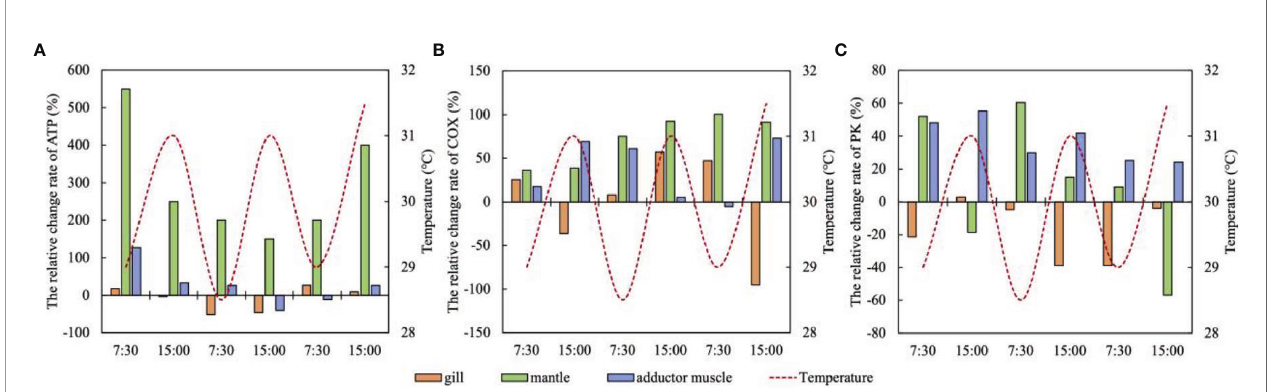
FIGURE 10 | The relative change rate of metabolic indexes (A ATP; B COX; C PK ) of the gill, mantle and adductor muscle under high temperature fl uctuations (means, n = 5).